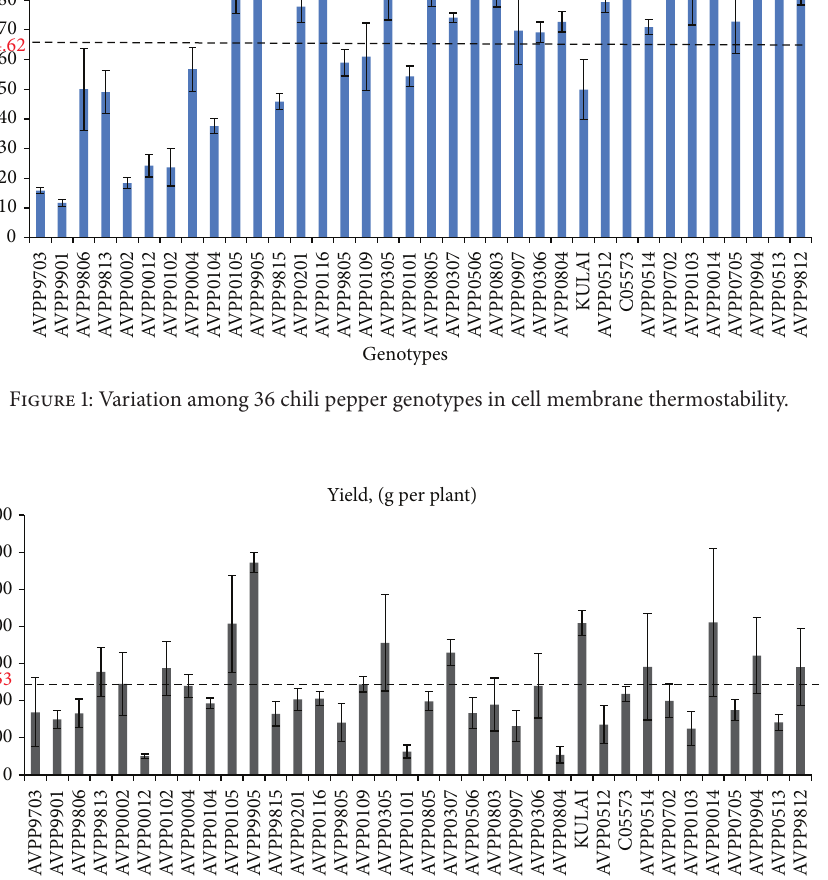
Figure 2: Variation in yield per plant for 36 genotypes of Capsicum spp.